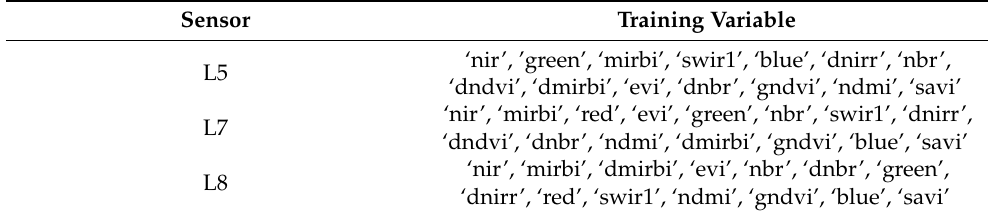
Table 4. Variables used to train the model, based on the order of importance for each